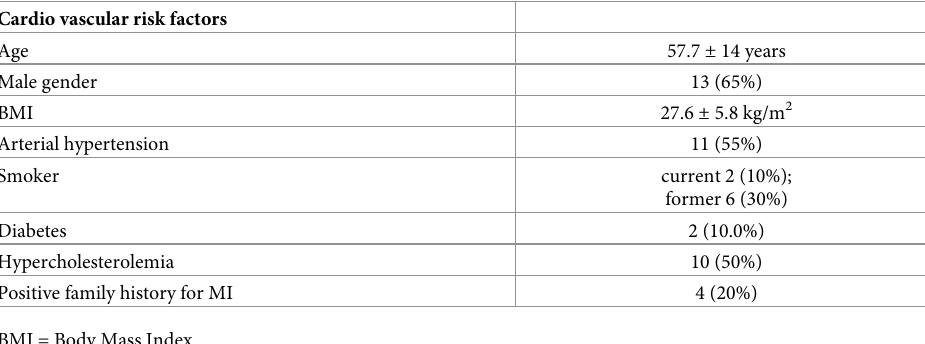
Table 1. Patients